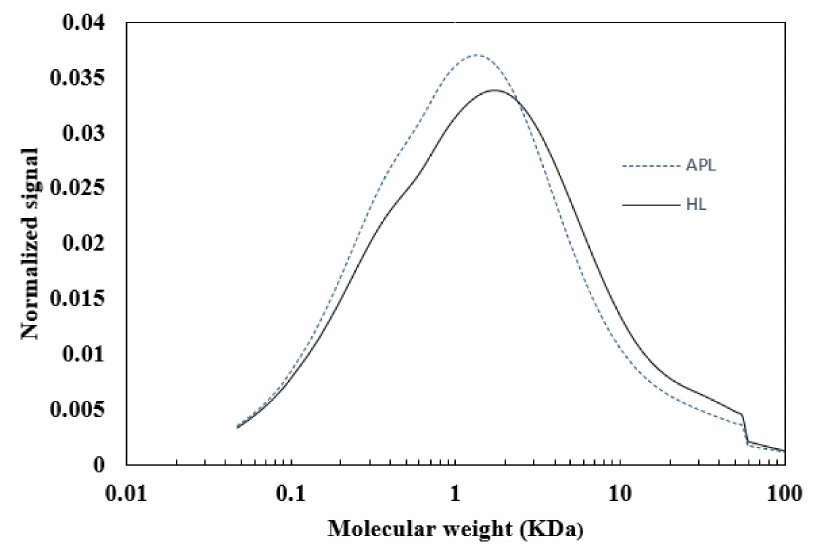
Figure 2. The molecular weight distribution of the APL and HL was analyzed using